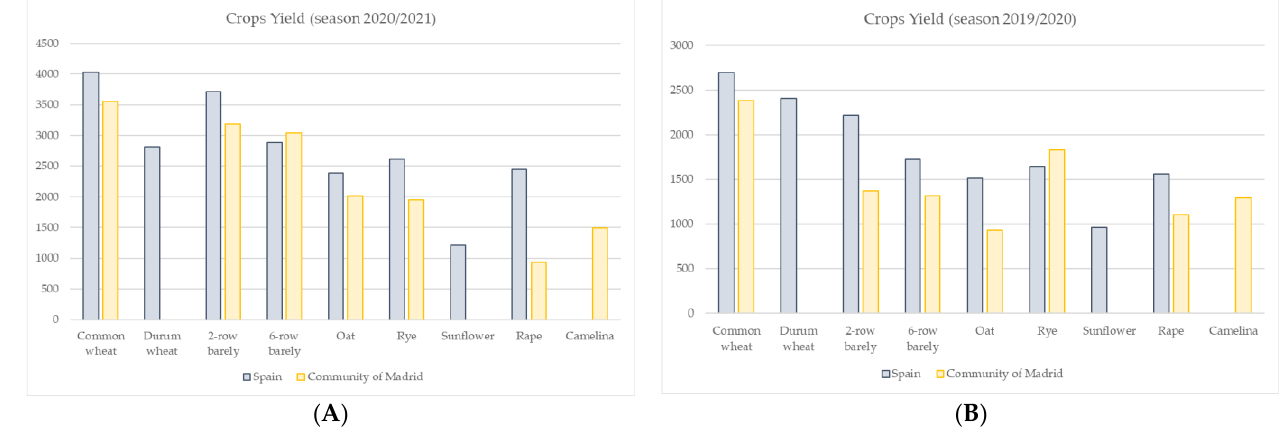
Figure 2. Camelina yield compared to other crops in Spain and in the Community of Madrid (Data obtained from Ministry of Agriculture, Fisheries, and Food of Spain: Encuesta sobre Superficies y Rendimientos Cultivos).